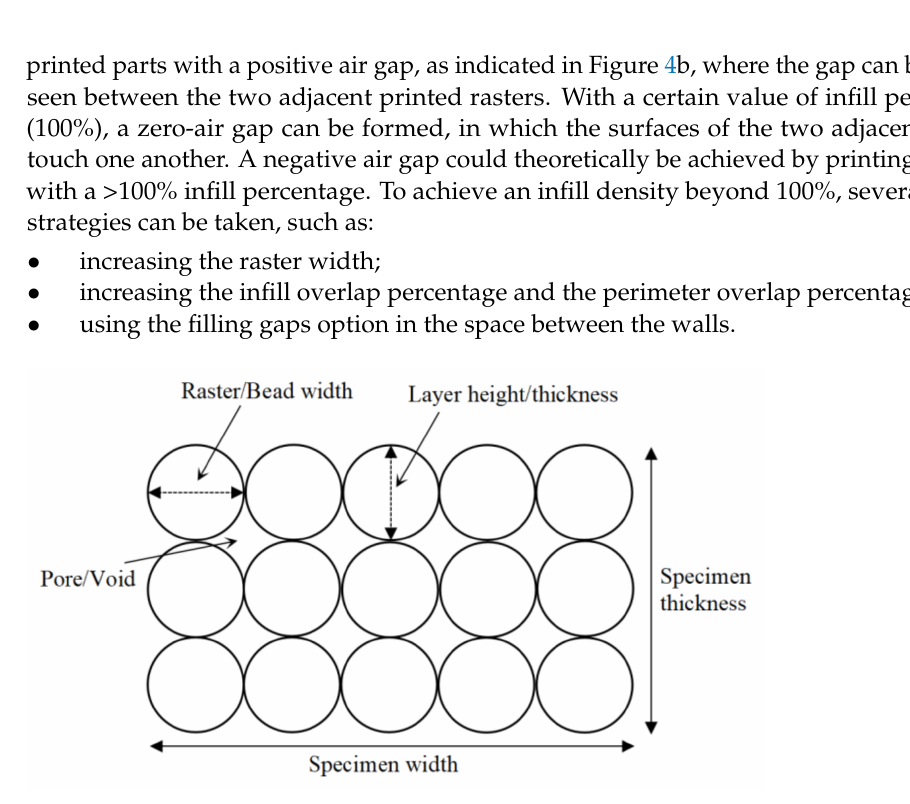
Figure 3. Schematic illustration of the layer height and raster width.